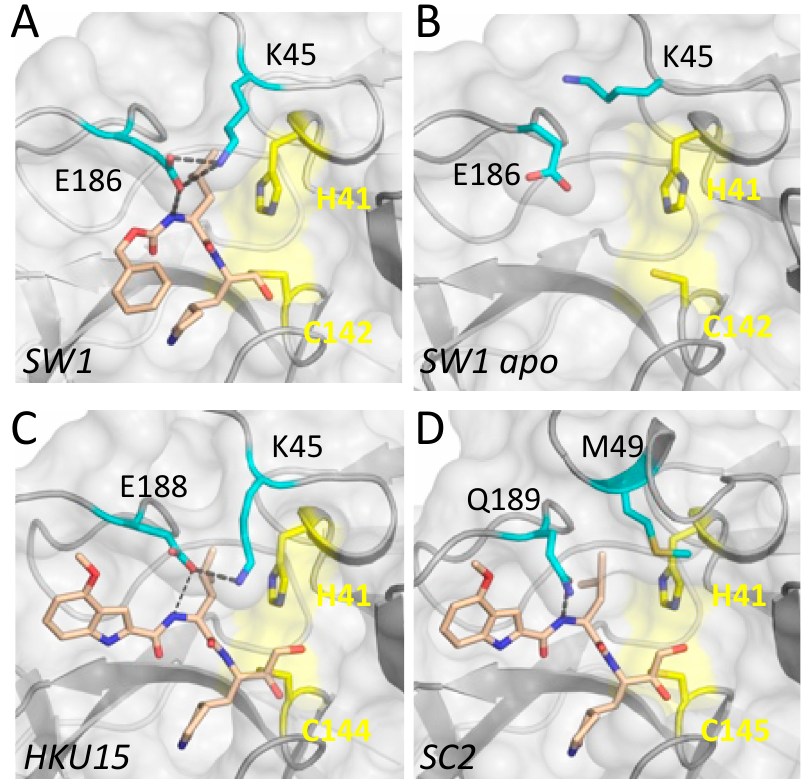
Figure 3. Salt bridge involving the 180s loop in delta- and gamma-CoV M pro crystal structures. ( A ) Inhibitor-bound M pro from beluga whale gamma-CoV SW1. The side chains of residues K45 and E186 establish a salt bridge over the P2 moiety of the bound inhibitor. ( B ) The salt bridge is missing in the apo structure of SW1 M pro . ( C ) Inhibitor PF-00835231 bound to M pro from porcine delta-CoV HKU15. The salt bridge is between K45 and E188. ( D ) There are no residues that can form a similar salt bridge in alpha or beta-CoV M pro variants, as shown for SARS-CoV-2 (SC2). In all panels, the protease is depicted in gray surface representation, and the catalytic residues are colored yellow.